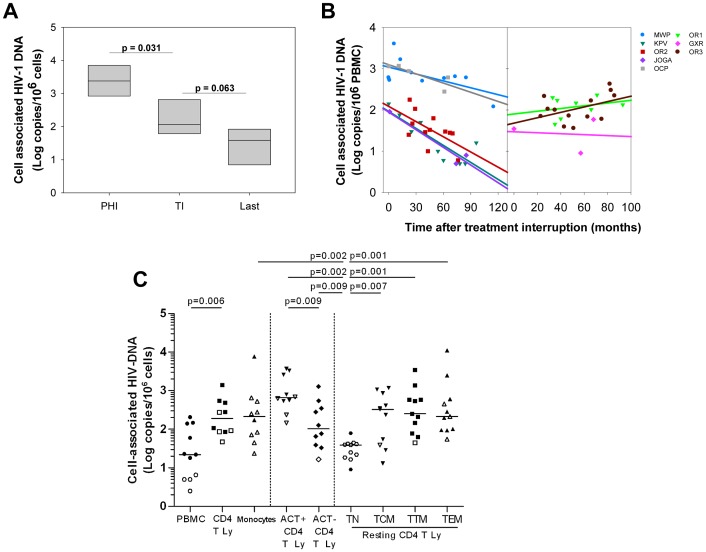
Post-treatment controllers have very low levels of cell-associated HIV DNA which keep decreasing after treatment interruption for some patients.
A. Levels of cell-associated HIV-1 DNA (median and IQR) in 6 PTCs at PHI, just before or at treatment interruption (TI), and the last available value obtained at a median of 6 years after cART discontinuation (Last). B. The evolution of cell-associated HIV DNA after treatment interruption in PBMCs from 8 PTCs. The slope of the evolution of HIV-DNA levels after treatment interruption was calculated by linear regression (lines) of the available sequential measures (symbols). Five PTCs experienced a decline of their cell-associated HIV-DNA levels (left); two PTCs maintained stable levels and a positive slope was calculated for OR3 (right). C. Infection levels in various cell populations from 11 PTCs: PBMCs, CD4+ T cells and monocytes; activated and resting CD4+ T cells; resting naïve (TN), central memory (TCM), transitional memory (TTM) and effector memory (TEM) CD4+ T cell subsets (see Figure S2 for the sorting strategy). The open symbols represent values below the threshold of detection. The medians are represented. A, B, C. The results are expressed as the log10 HIV DNA copy numbers per million cells.